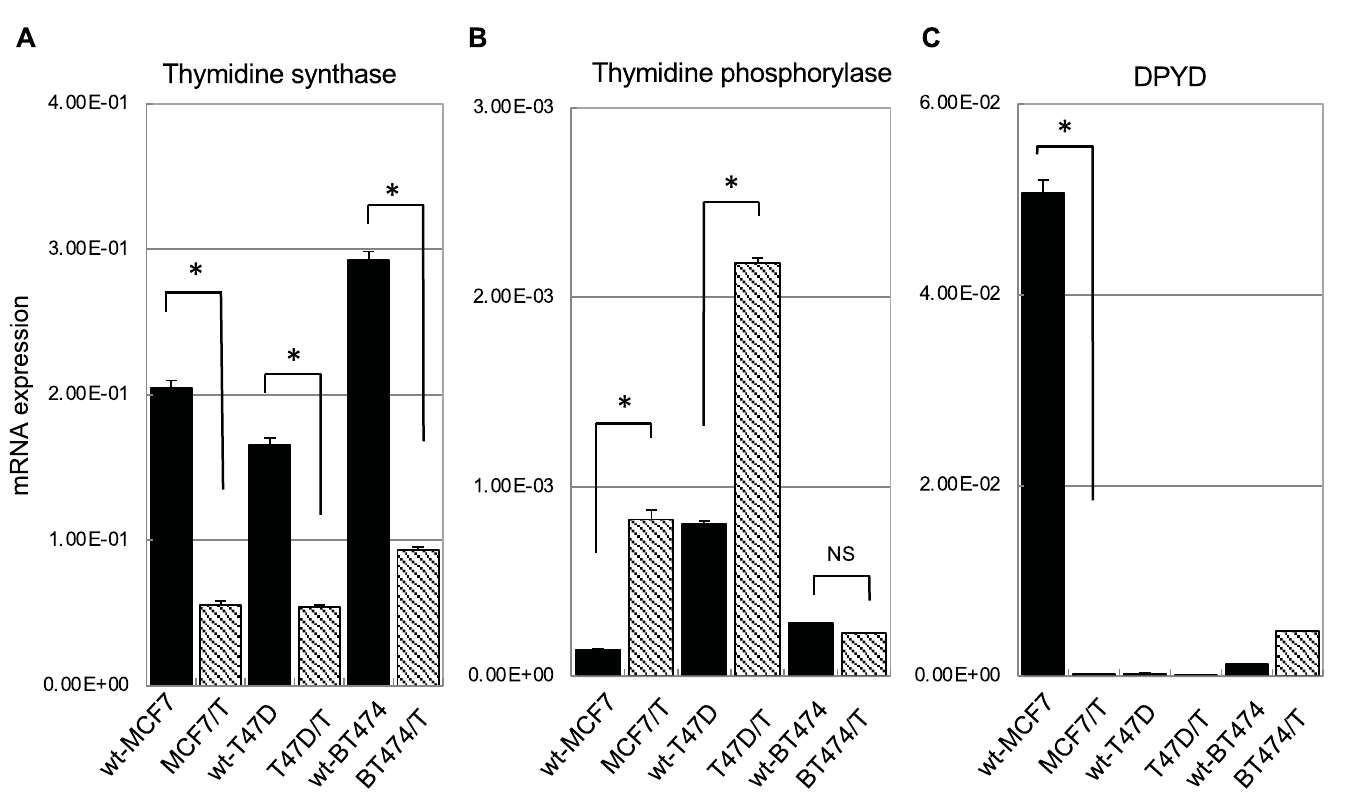
Fig 4. The expressions of thymidine synthase, thymidine phosphorylase, and dihydropyrimidine dehydrogenase in ER-positive breast cancer cell lines and their tamoxifen-resistant sublines. The mRNA expression of thymidine synthase (A), thymidine phosphorylase (B), and DPYD (C) were quantified by real-time RT-PCR in ER-positive wild-type cell lines (MCF7, T47D, and BT474) and their TAM-resistant sublines (MCF7/T, T47D/T, and BT474/T). β -actin was used as an internal control. The error bars in each graph represent the standard deviations of the values obtained in the experiments performed in triplicate. The experiments were repeated independently at least three times, and one representative result is provided in the figures. NS, not significant; � p < 0.05, by unpaired Student’s t -tests.